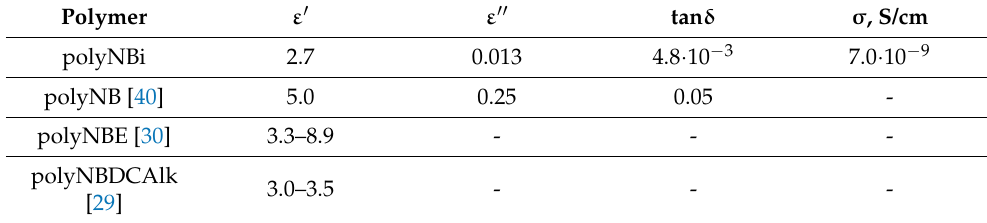
Figure 6. The frequency dependences ( a ) and the temperature dependence (( b ), at 1 MHz) of ε ’ for polyNBi. Table 5. Dielectric properties of some polynorbornenes (the values are given at 1 MHz and 298 K).